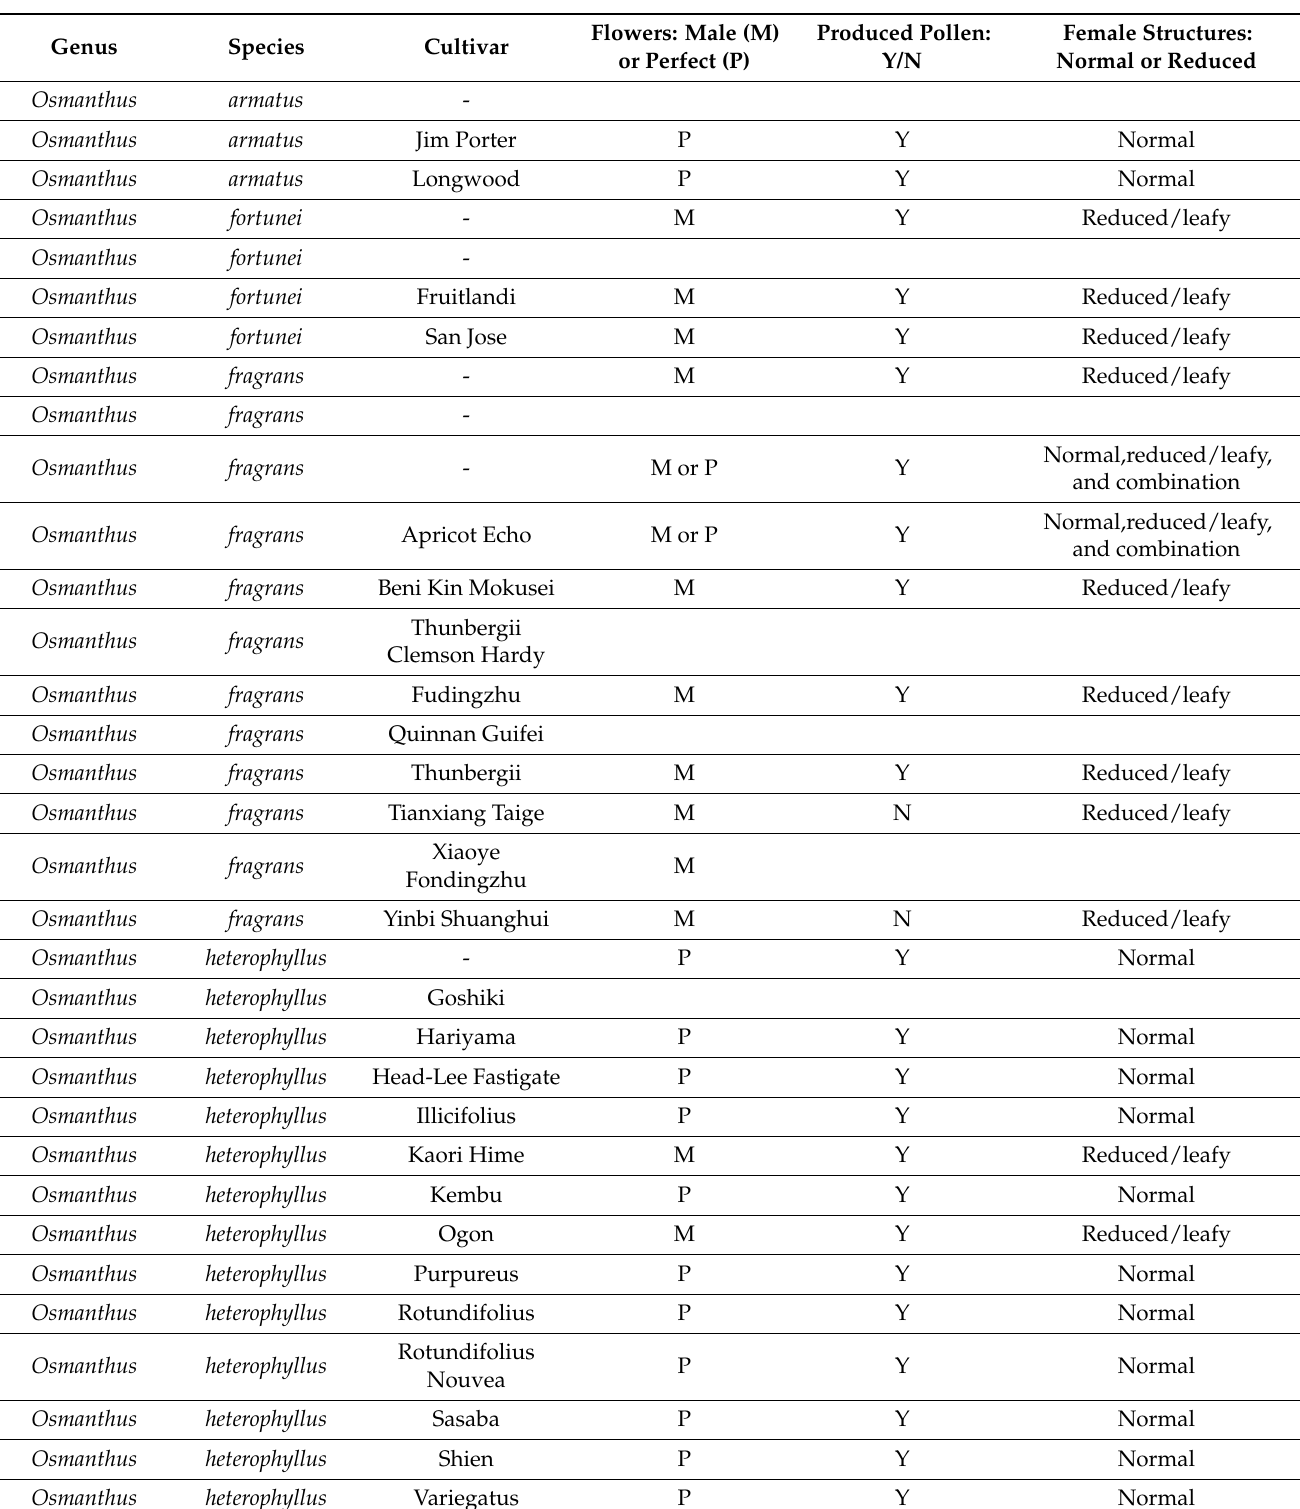
found in five of the seven O. fragrans , while the other two lacked pollen completely (Table 4). Table 4. Floral morphology and presence or absence of pollen for four species of Osmanthus in McMinnville, TN, USA. A dash (-) indicates an unnamed seedling. Missing values indicate the accession did not flower during the observation